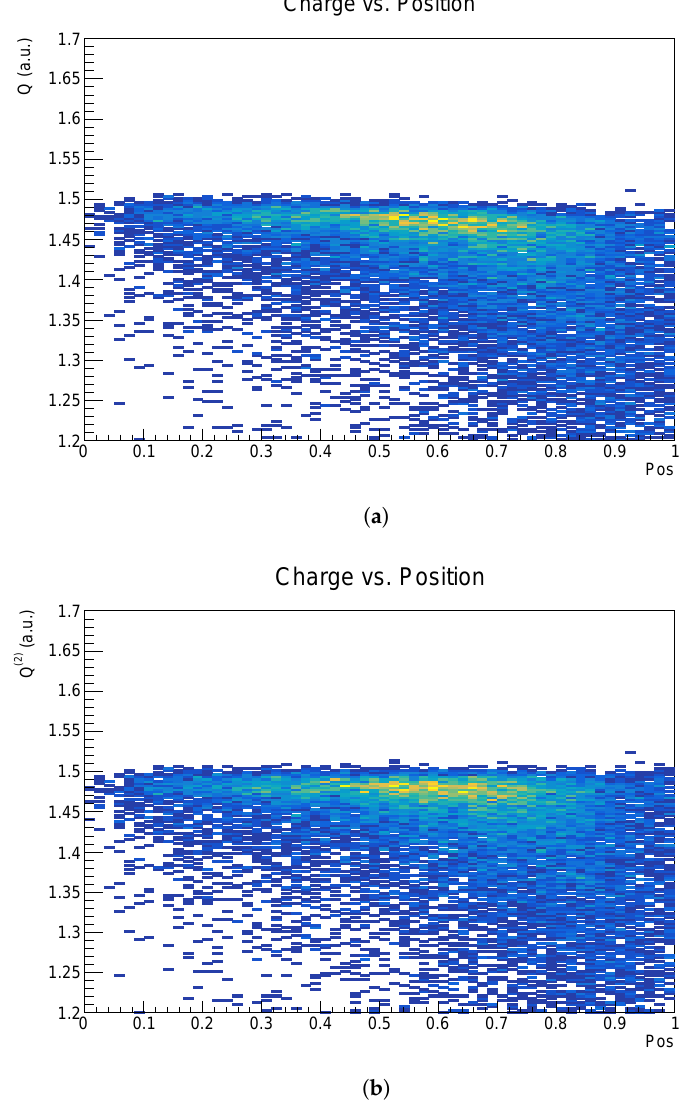
Figure 5. Charge versus reconstructed position of the hit. The position is chosen such that 0 refers to the centre of the crystal and 1 to the edge. See (6) for details. ( a ) Uncorrected. ( b ) Corrected. While for corrected and uncorrected charge it is clearly visible that the distribution widens up for more lateral hits, the uncorrected charge distribution is slightly tilted. This effect is mostly removed by applying the correction to the